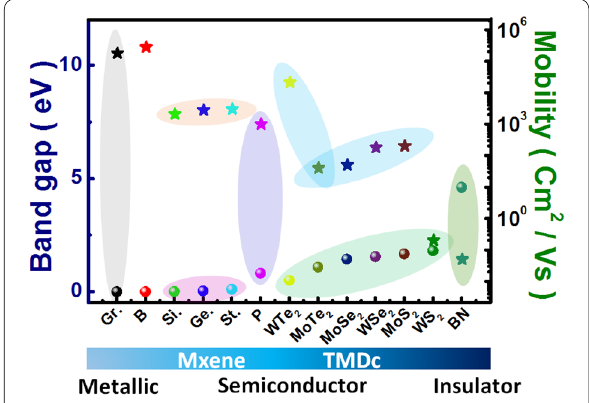
Fig. 4 Bandgap versus mobility of various 2D materials